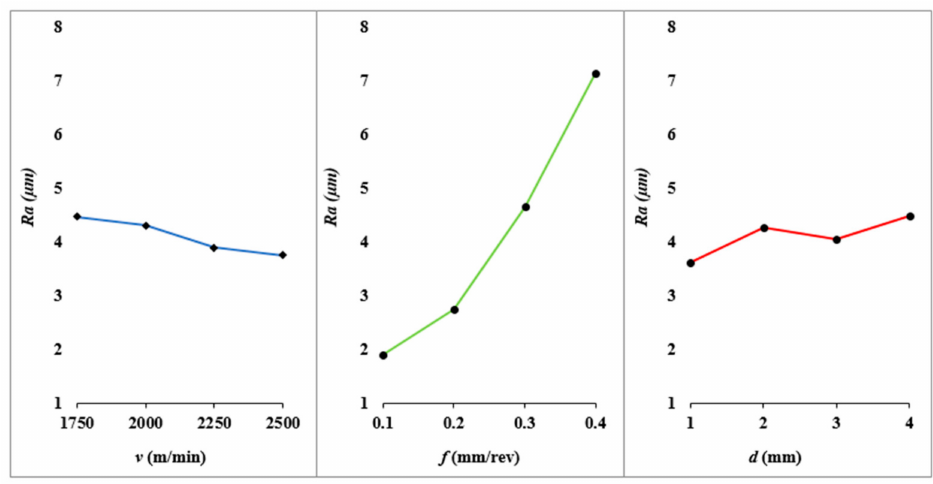
Figure 10. Main effect plot showing the influence of cutting parameters on Ra in HSM.